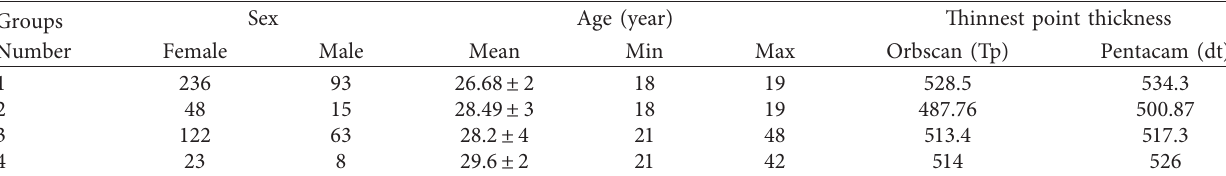
Table 2: Comparison of age, gender, and thickness of the corneal thinnest point in the Pentacam and Orbscan of participants for each group.